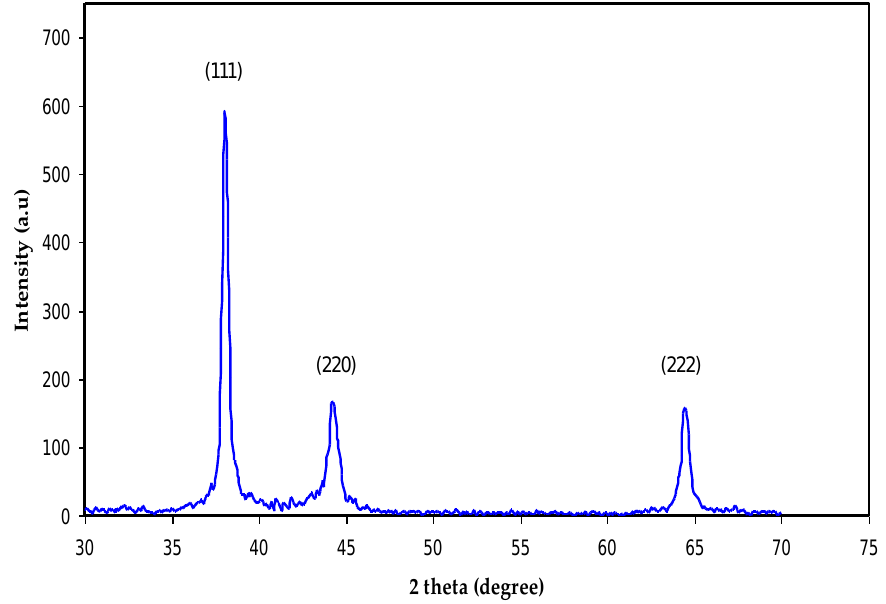
Figure 6. XRD pattern for biosynthesized Ag NPs at ambient temperature.